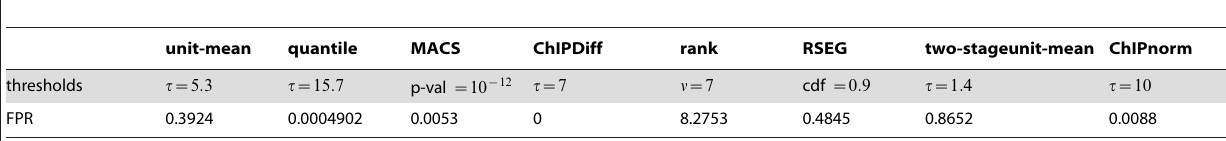
Table 3. False-positive rate (FPR) analysis for human ES cells (H3K27me3 data from ENCODE Broad database) for the two